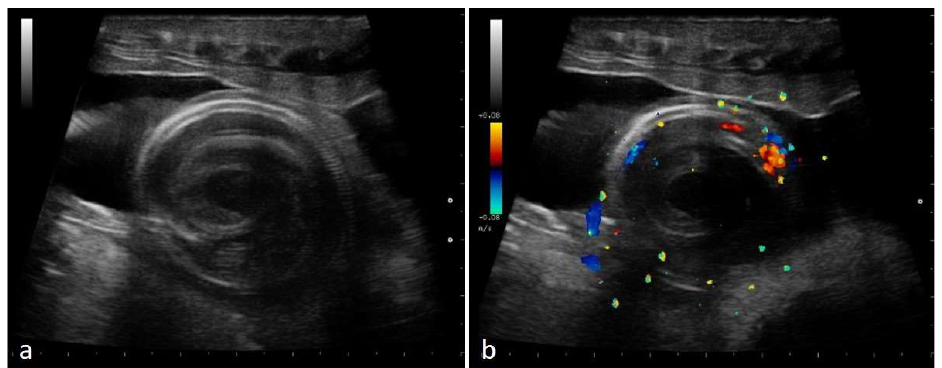
Figure 15. Gravid female boa 77 days after ovulation, 57 days after post-ovulatory shed—flow towards the transducer is depicted in red, while flow away from the transducer is shown in blue. In all females who have given birth to live offspring, embryos showed a spiral appearance, and ribs were well recognizable ( a ). By using color Doppler, it was possible to evaluate vascularization ( b ).